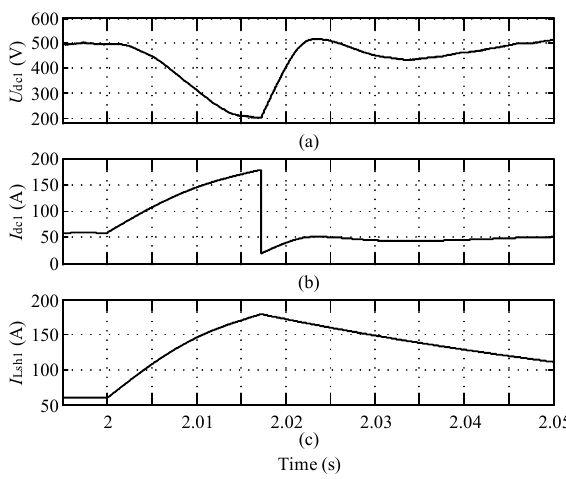
Figure 10. Simulation curve of VSC side of large current bipolar short circuit (local enlargement). ( a ) Capacitor C 1 voltage U dc1 . ( b ) VSC-side cable current I dc1 . ( c ) current over current limiting inductor in FCL1 I Lsh1 .